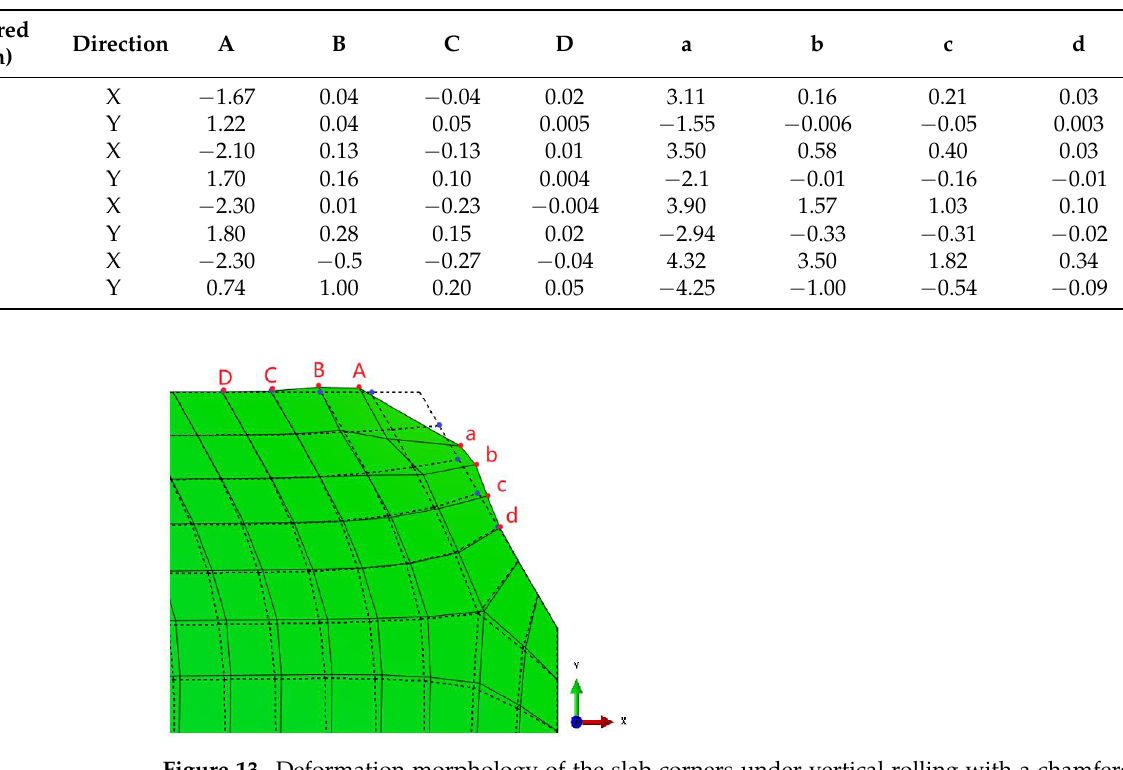
Table 4. Node deformation at different two-chamfered lengths under vertical rolling (mm).